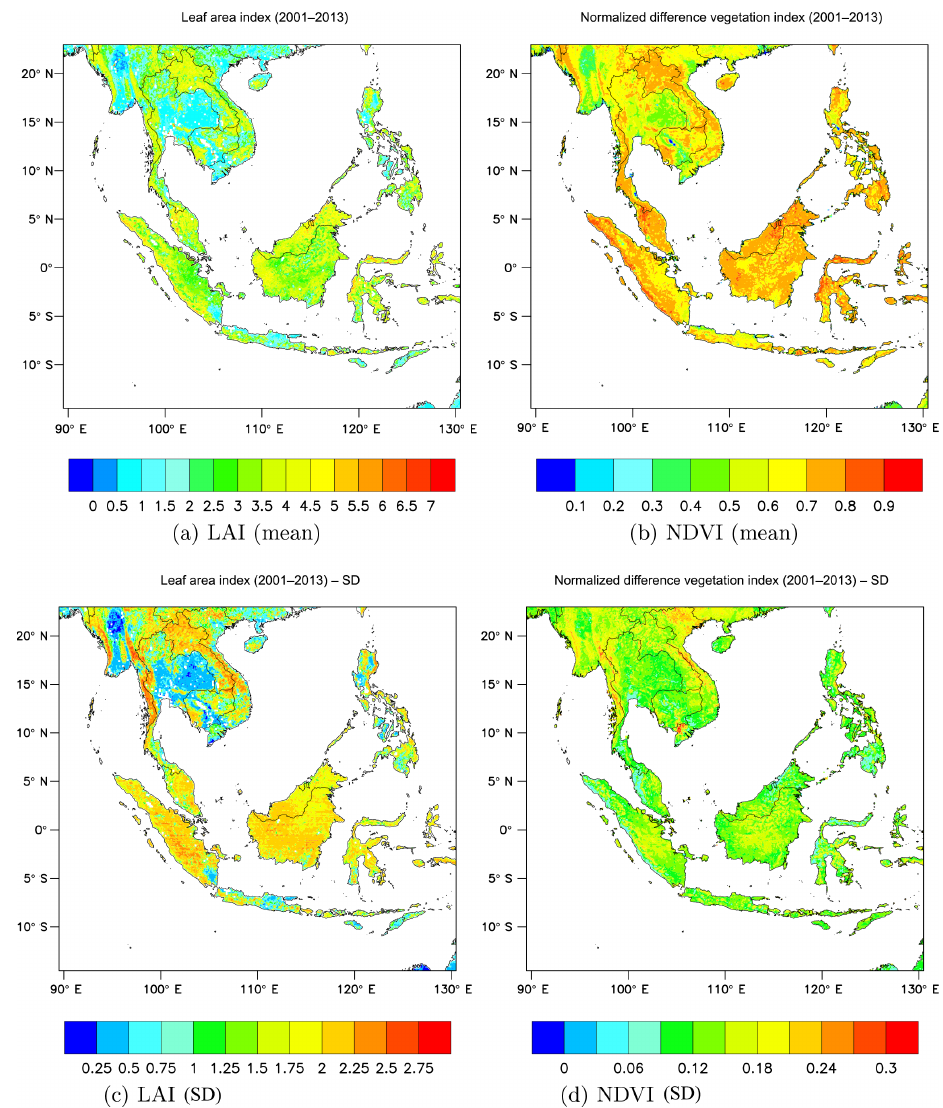
Figure 3. Climatological values of LAI (first column) and NDVI (second column) for the 2001–2013 period. Average values are displayed on the first line, while the standard deviation is displayed on the second line. Table 1. Average error and correlation between AOD at 0.55µm from MODIS and reconstructed AOD with different